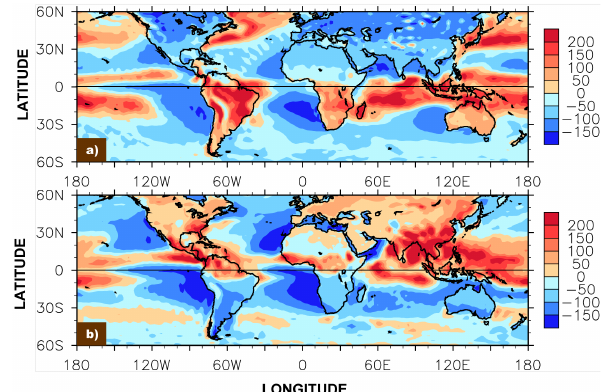
Fig. 1. Distributions of column-integrated total heating averaged over the period 1980–1997 for January (a) and July (b) . Unit is Wm − 2